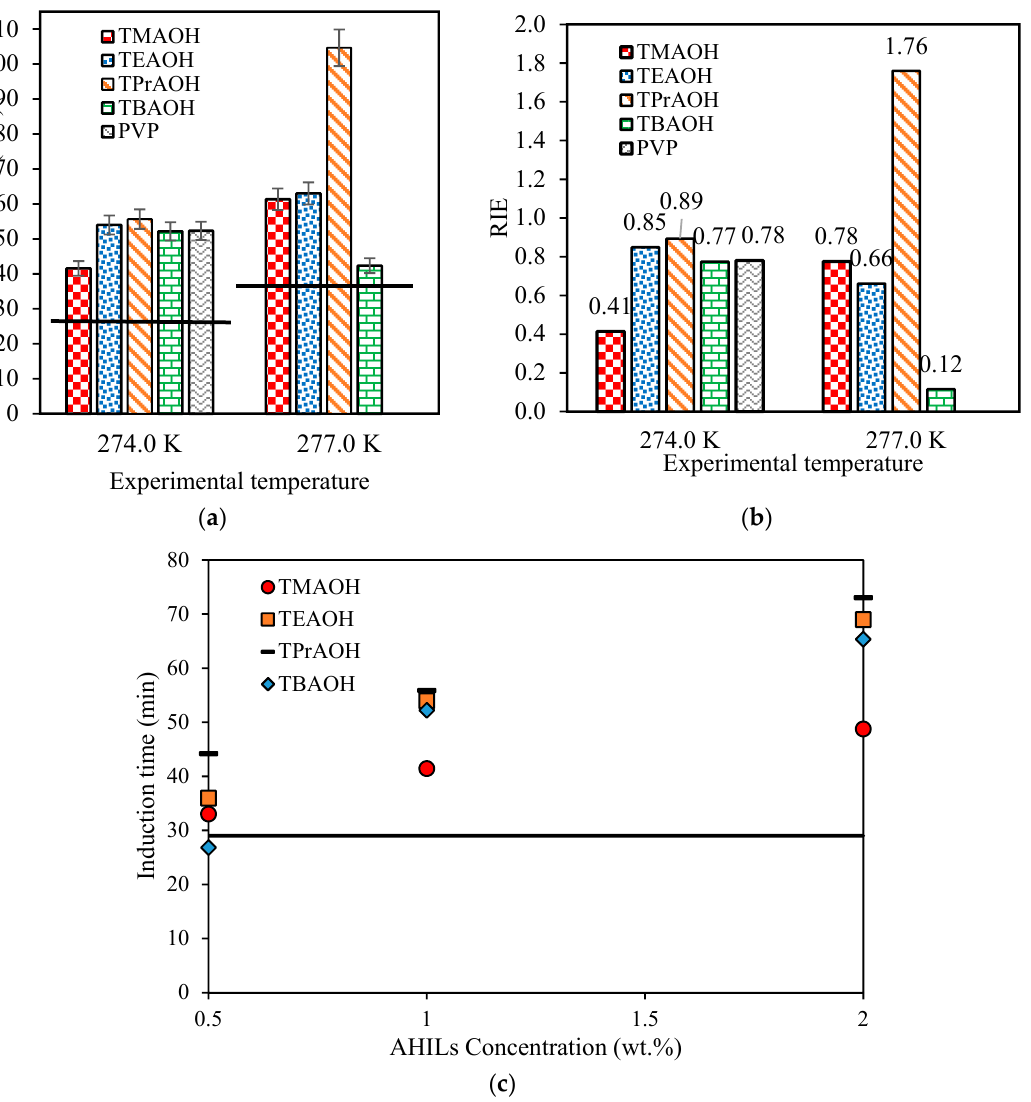
Figure 3. Effect of AHILs on the measured CH 4 hydrate induction times at different experimental temperatures at 1 wt.%: ( a ) Induction time at 274.0 and 277.0 K; ( b ) RIE for the CH 4 hydrate system; ( c ) Effect of AHILs concentrations on the methane hydrate formation induction time at 274.15 K; The black line symbolizes pure water values; No hydrate formation was observed for PVP at 277.0 K.